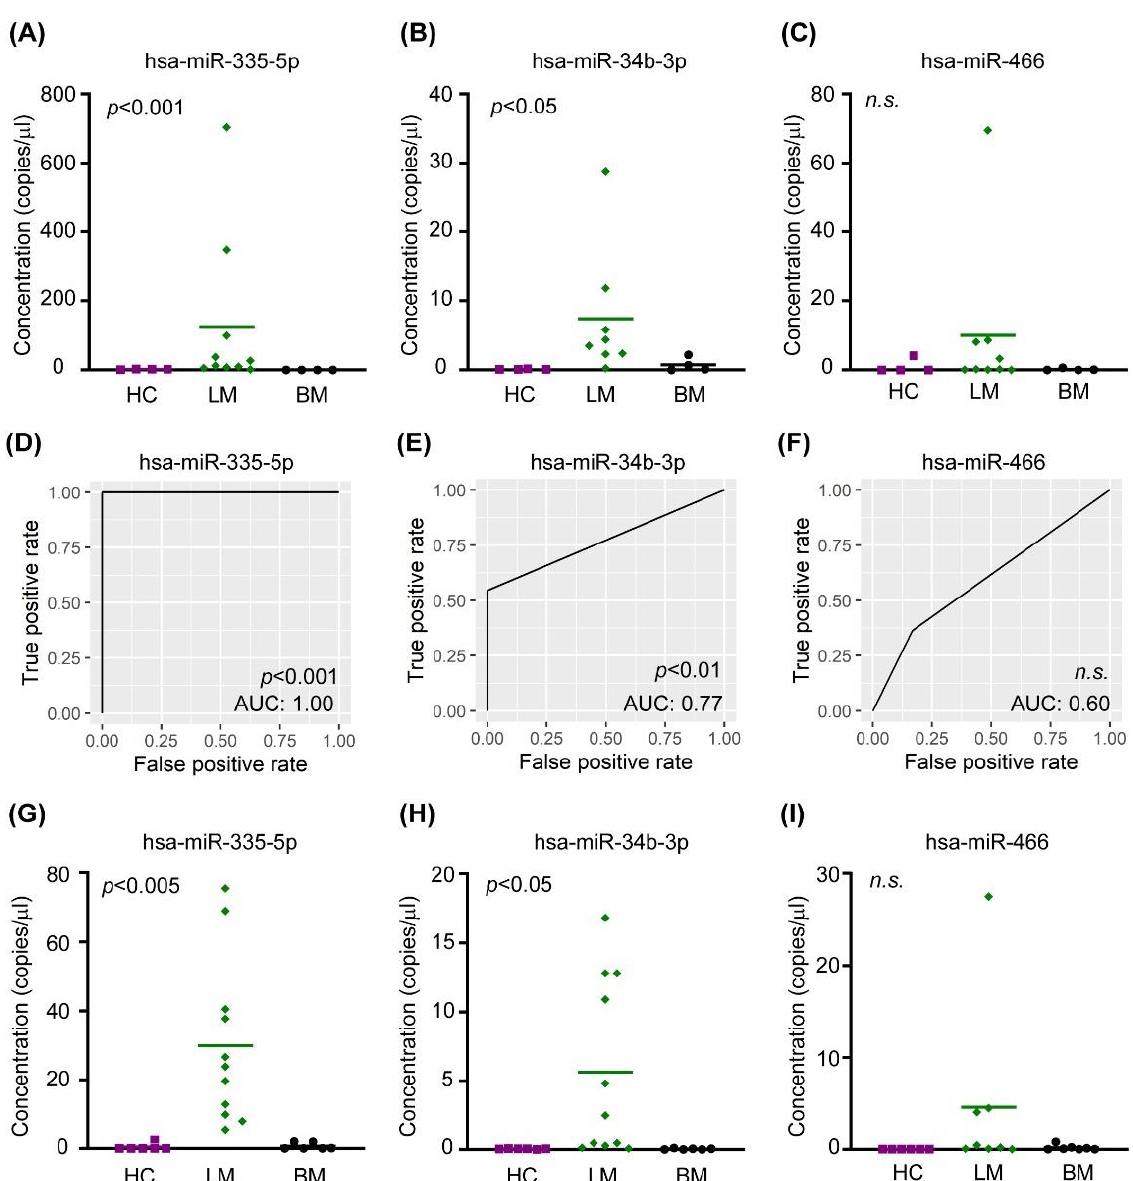
Figure 5. Internal and external validation of the representative discriminative miRNAs by digital droplet PCR (ddPCR) with corresponding analysis of Area Under the Receiver Operating Characteristics (ROC) for LM. ( A – C ) Expressions of indicated miRNAs were determined through ddPCR in the discovery sample set (HC n = 4, BM n = 4, LM n = 8–10). Two sample t -test p -values between LM and non-LM were calculated in Prism software. ( D – F ) The area under the ROC of indicated miRNA was calculated using R software (version 3.6.0). ( G – I ) Expressions of indicated miRNAs were determined through ddPCR in the validation sample set (HC n = 6, BM n = 6, LM n = 11). Bar represents mean value. Abbreviations: HC, healthy control; LM, leptomeningeal metastasis; BM, brain metastasis.